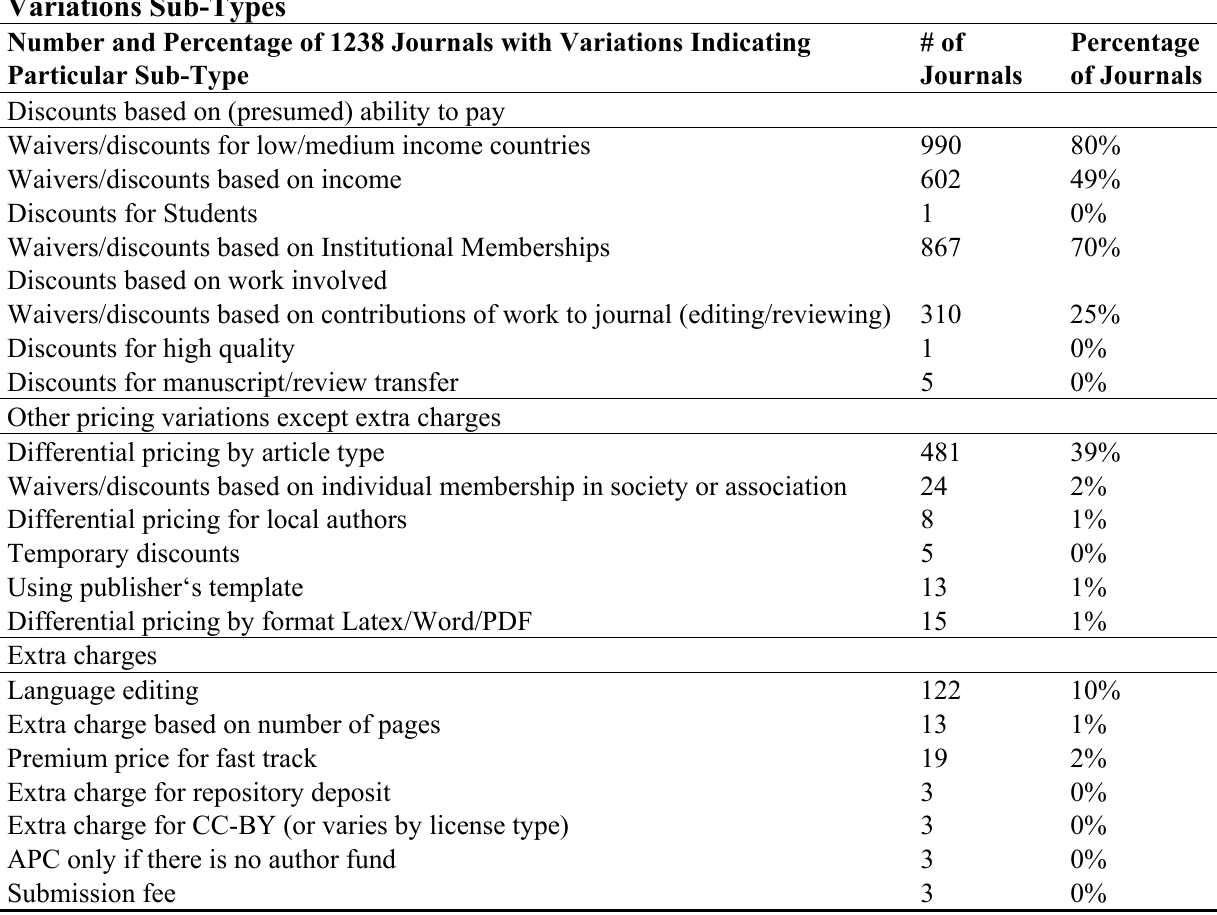
Table 7. Frequency of sub-types of